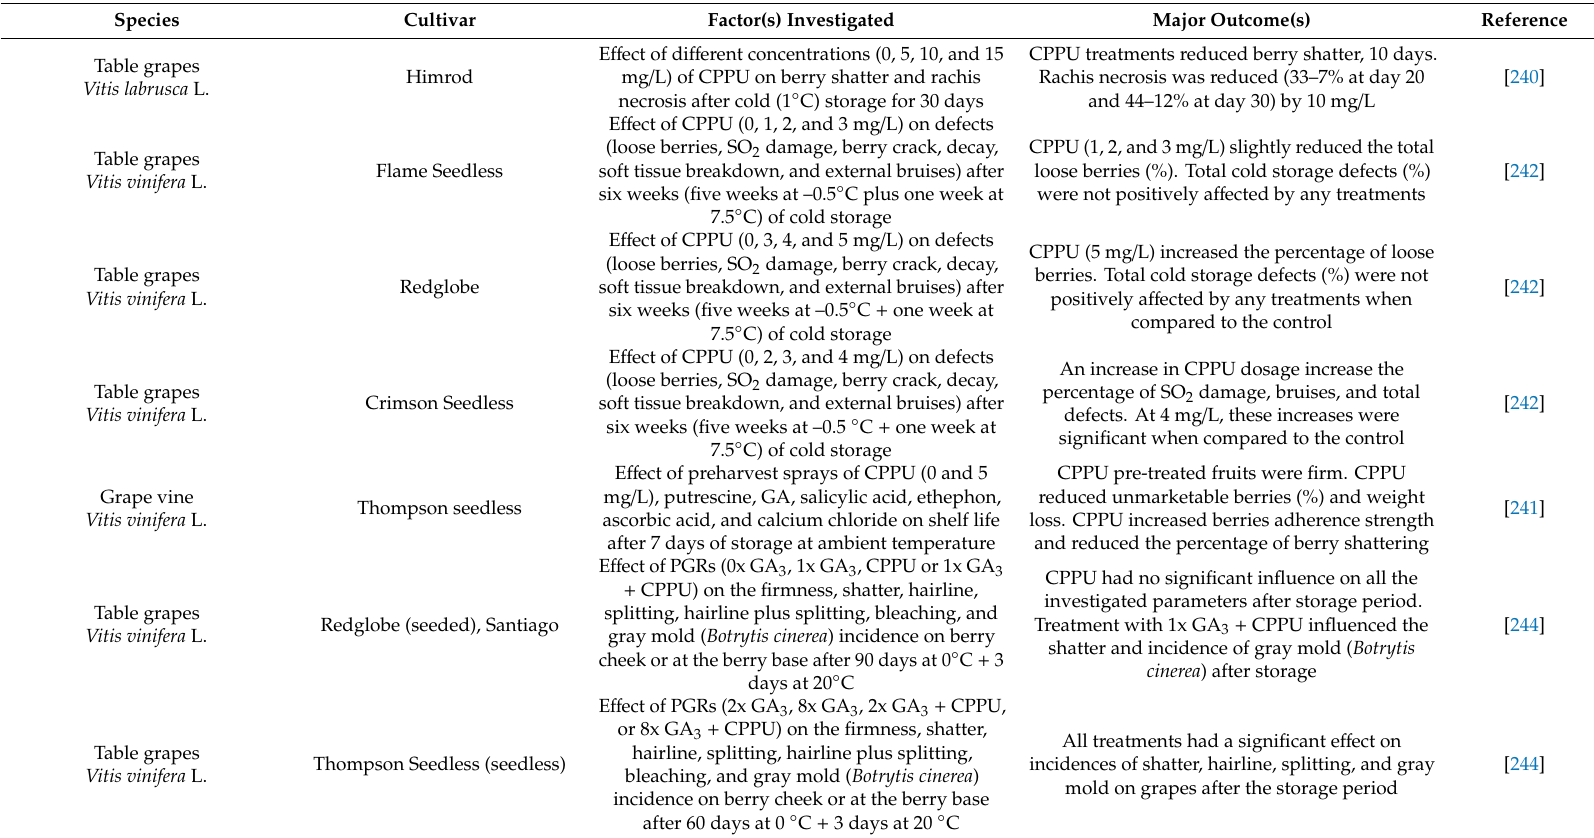
Table 7. E ff ects of preharvest application of cytokinins on postharvest quality of horticultural fruits.